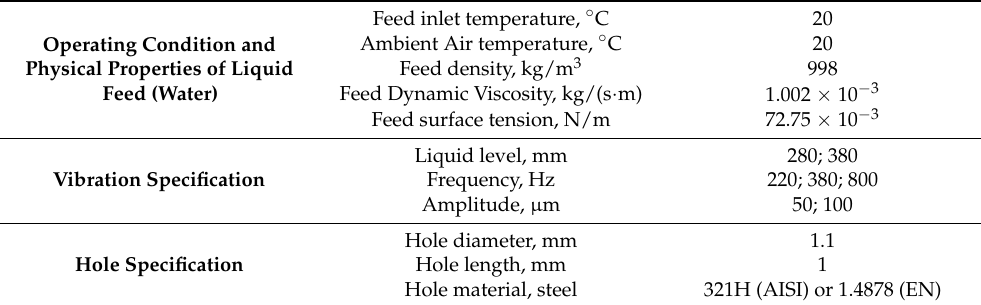
Table 1. Operating condition/specification of the experimental